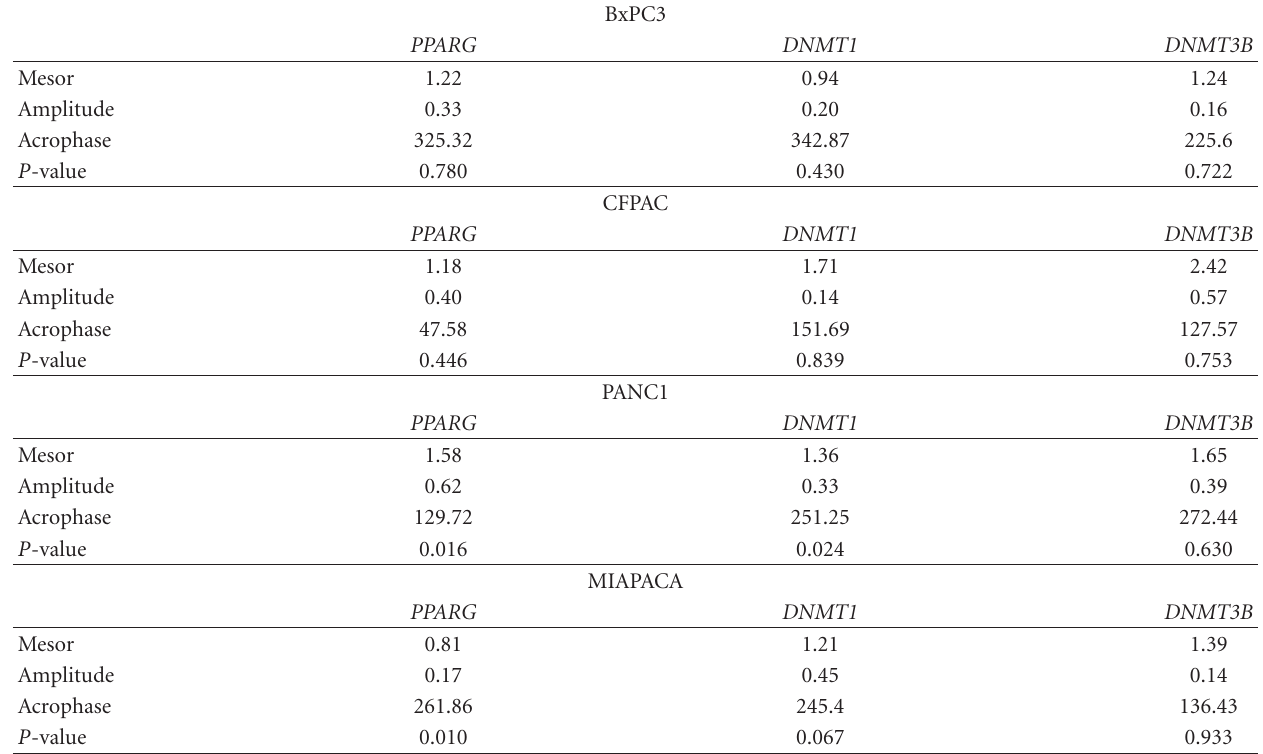
Table 1: Rhythm parameters from fitted single cosinor models for mRNA expression calculated on original values normalized to the first time point of sample collection after serum